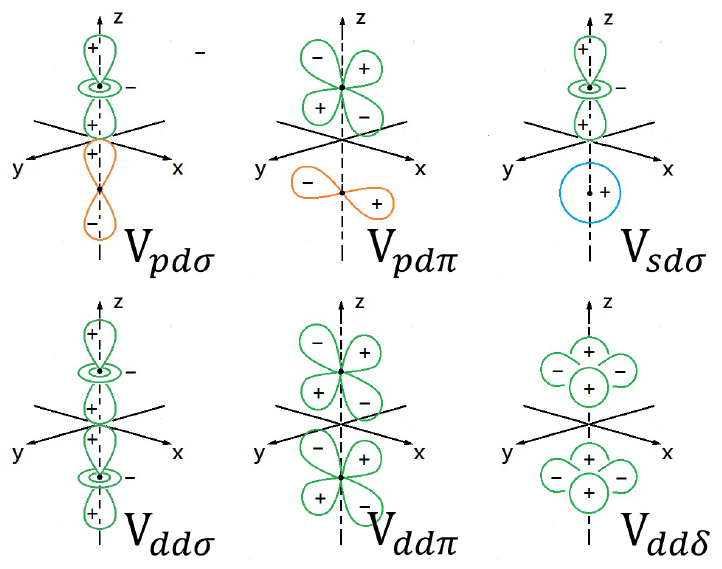
Figure 4. Illustrations for π , σ and δ bonding of atomic s , p , and d orbitals. Details on description of these bonding orbitals in this figure can be found in